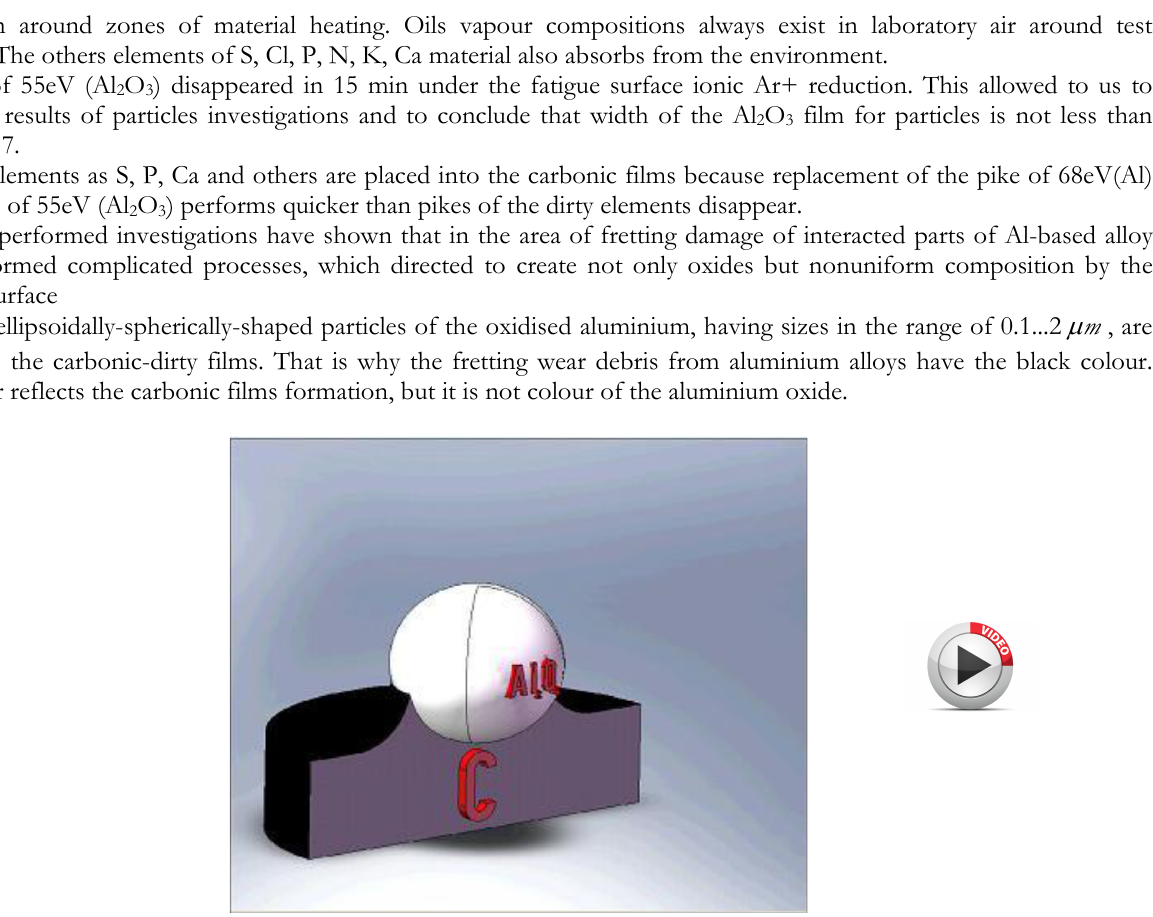
Figure 7: Schema one of spherical particles placed in “C” - carbon lyre, with indication of Al2O3 as this particle skin.